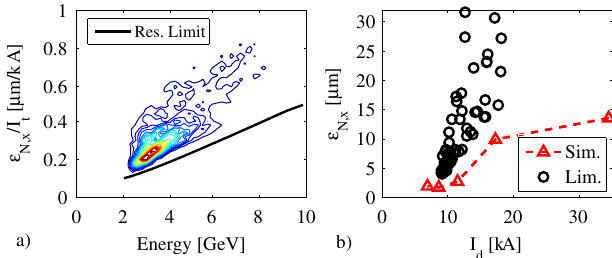
FIG. 5. (Color) (a) A contour plot of the measured upper limit for (cid:1) N;x =I t vs energy, obtained from Eq. (2), where the black line represents the system resolution. (b) The upper limit of (cid:1) N;x for the 65 events from the experiment (Lim.) is consistent with the values from simulations